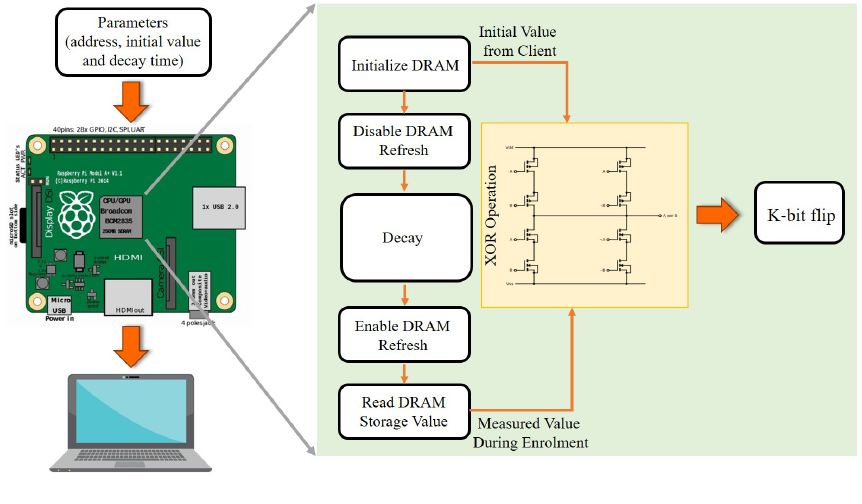
Figure 12. Structure of DRAM PUF implementation on Raspberry Pi.